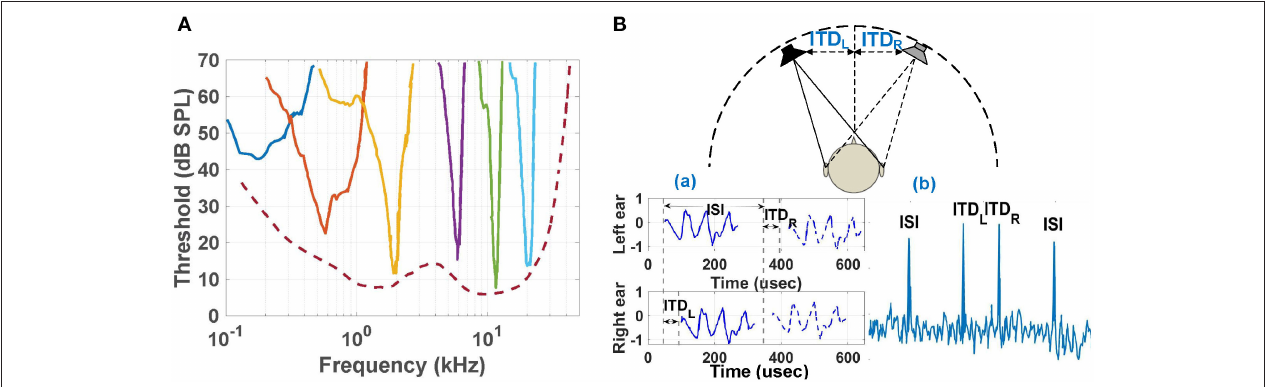
FIGURE 1 | (A) Neural frequency-threshold tuning curves in monkey (macaque) for 9 selected frequencies, adapted from Joris et al. (2011) and Verschooten (2013). (B) (a): Schematic of the input signals to the two ears when two loudspeakers, separated in azimuth, emit identical sounds with a slight delay ( ISI ). ITD L and ITD R signify the interaural time differences between signals from the two source locations for the left and right ears, respectively; (b): Cross-correlation between the two ears for broad-band outputs from the speakers. Four peaks occur at correlation delays ( τ ) corresponding to ± ISI , ITD L , and ITD R . Figure adapted from Keller and Takahashi